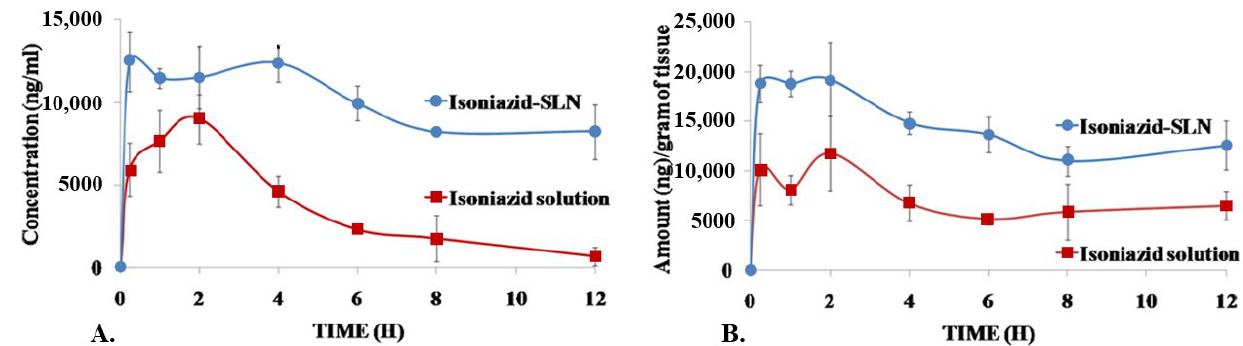
Figure 9. Concentration profiles for free isoniazid (INH) (red) and for INH-loaded solid lipid nanoparticles (SLNPs) (blue) after the oral administration of 25 mg/kg in rats. n = 6. ( A ) Results in plasma. ( B ) Results in the brain. Adapted from reference [107], copyright (2022) by Copyright Clearance Center, with permission from Elsevier.